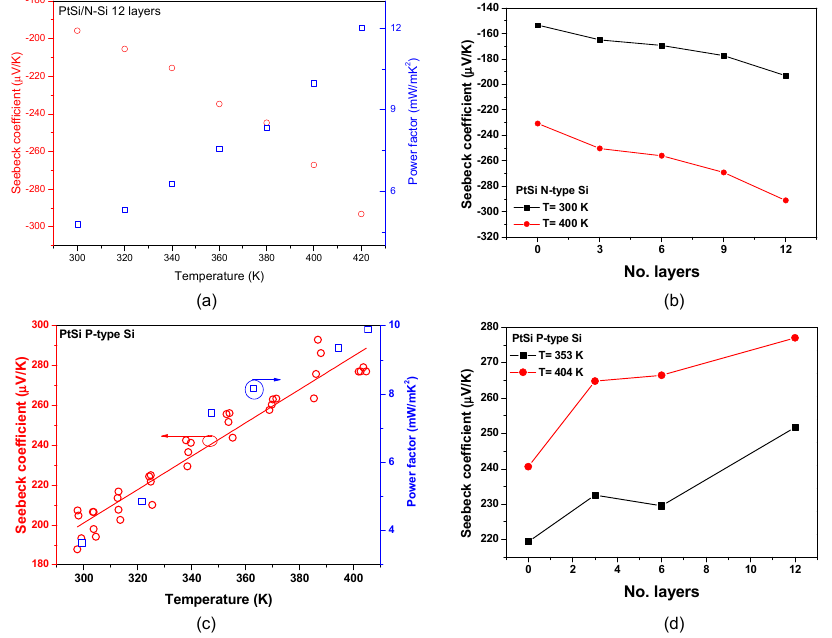
Figure 3. Seebeck coefficient and power factor of three-dimensional n -type thermoelectric materials according to ( a ) temperature and ( b ) layer numbers, and Seebeck coefficient and power factor of three-dimensional p -type thermoelectric materials according to ( c ) temperature and ( d ) layer numbers.